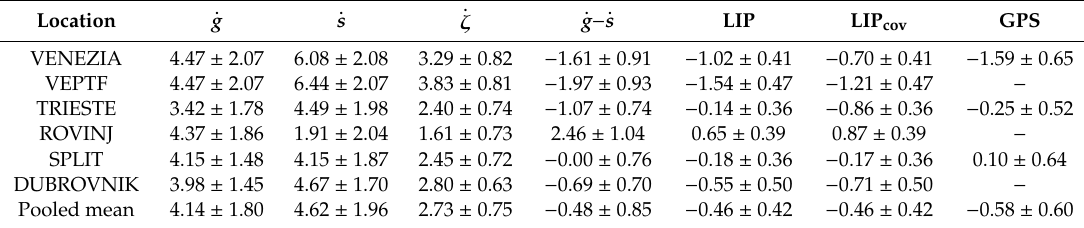
Table 4. Results of calculations using SLCCI altimetry dataset (1993–2015). Same columns as in Table 3. All data are in mm y − 1